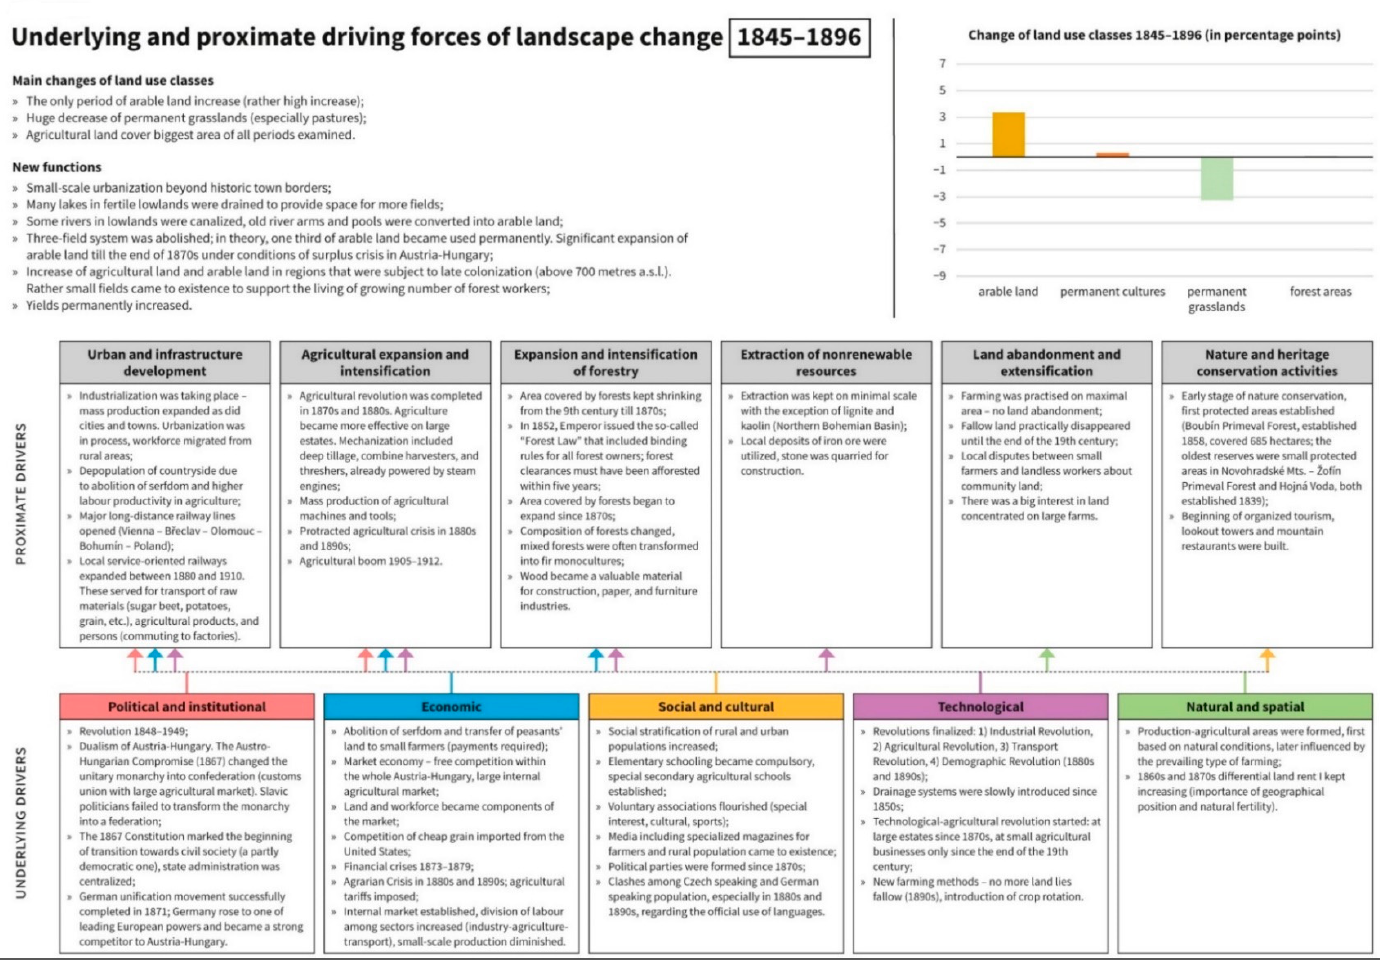
Figure A1. Underlying and Proximate Driving Forces of Landscape Change 1845–1896